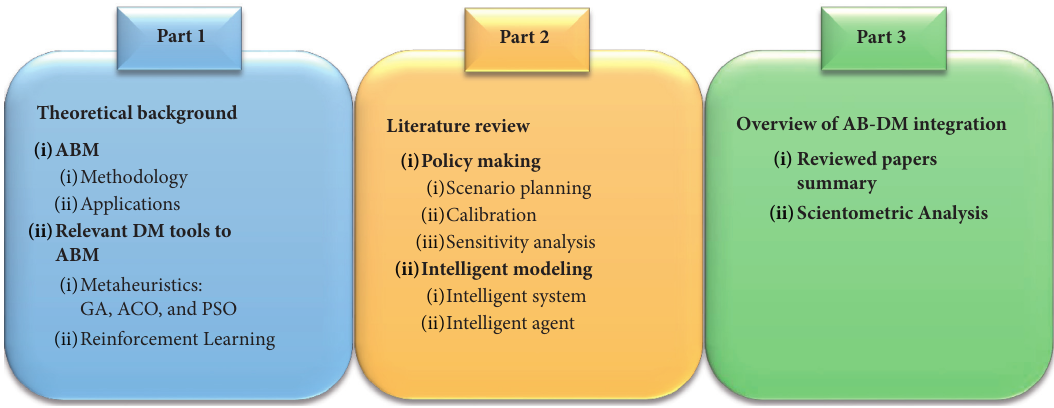
Figure 1: Road map of Section